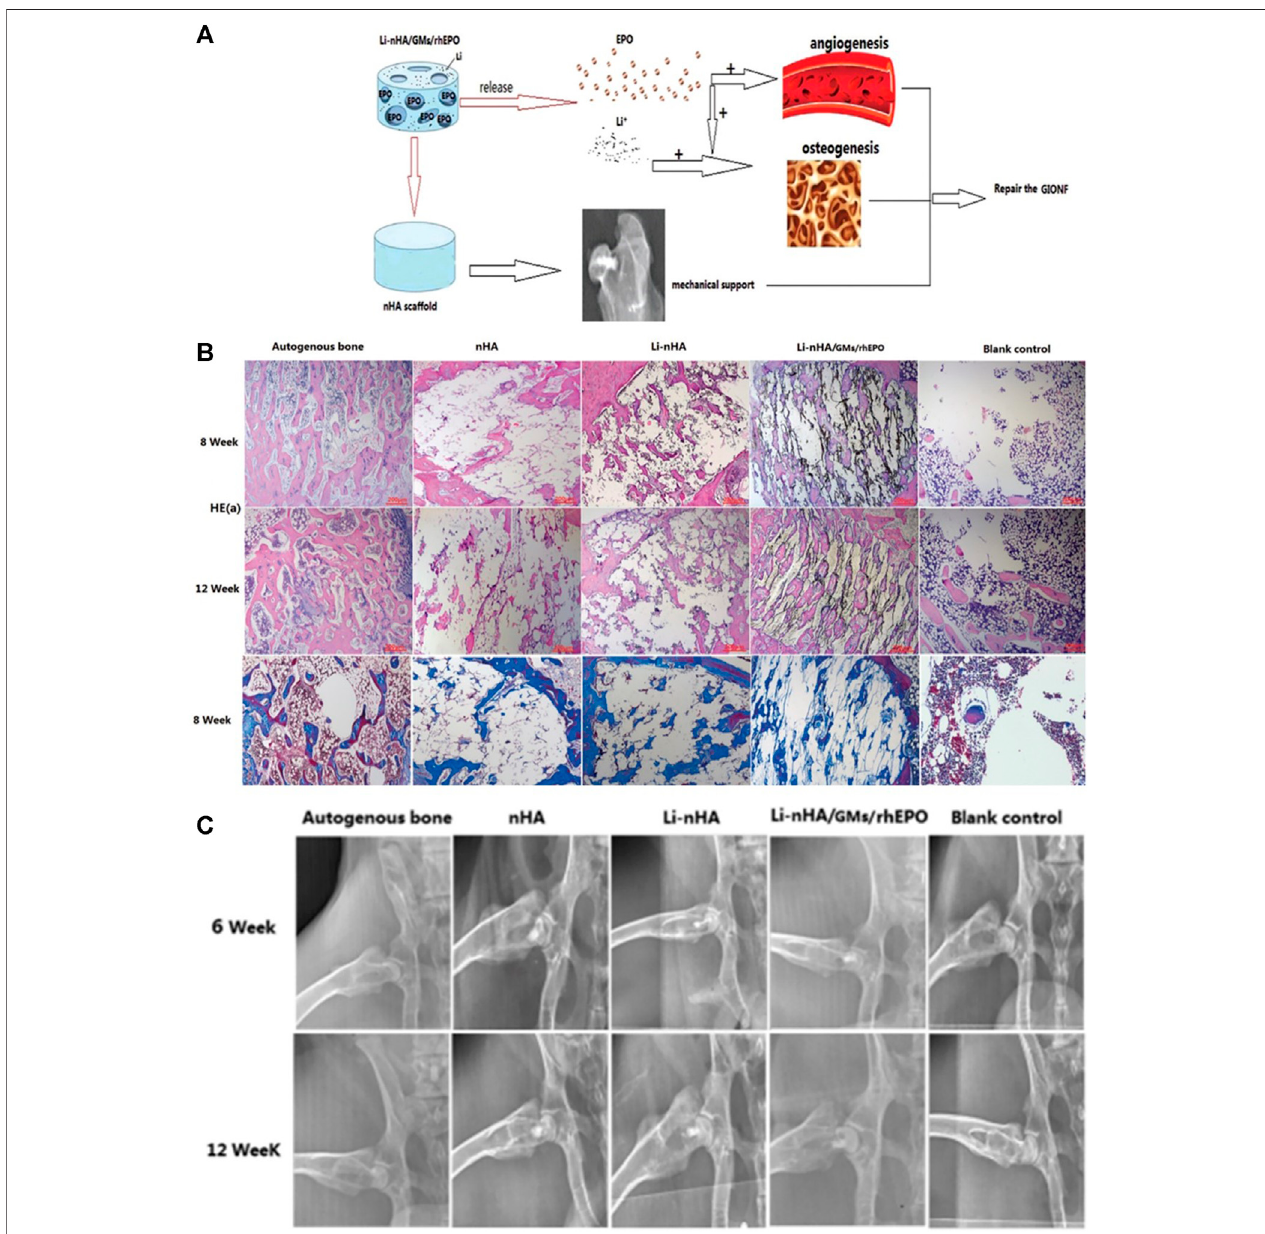
FIGURE 12 | Combination of EPO, Li and polymers to treat osteonecrosis. (A) Schematic of the composite scaffold design. (B) HE staining and Masson staining showingthebonedefectrepairinthedrillingchannels. (C) X-radiographicexaminationshowingtheimplantsinthefemoralheadandthemorphologyofthefemoralhead. Reproduced with permission (Li et al., 2018a). Copyright 2018, The Royal Society of Chemistry